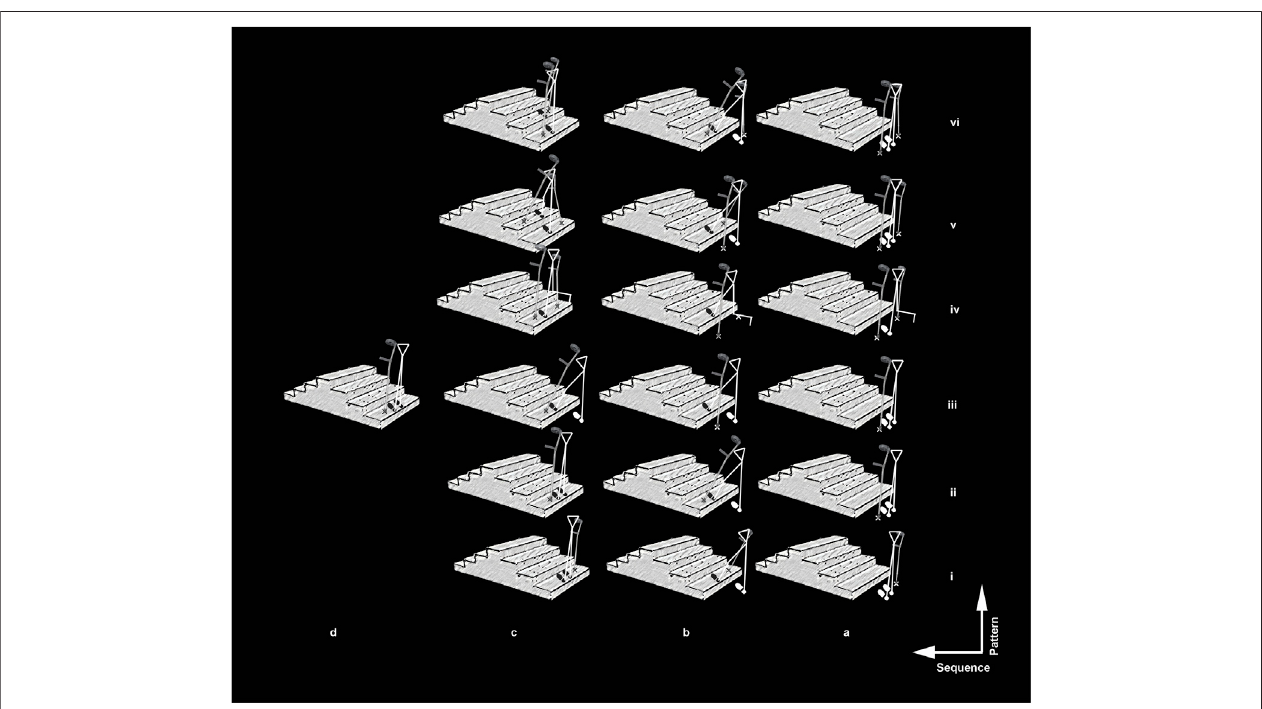
FIGURE2| Crutch locomotion patterns. Theimage showsahalfofthekinematic patternsusing crutchesinthestudy( n =6)fromitovi.Thetotalnumber ofcrutch locomotion patterns was 12, which resulted from changing the limb side to start the movement. In addition, the fi gure shows the movement sequence from letter ato d. Finally, the weight-bearing of the limb and crutch over the ground is indicated with a print stick fi gure and Canadian crutches. The stair ascending control (without crutches, n = 2) were omitted.